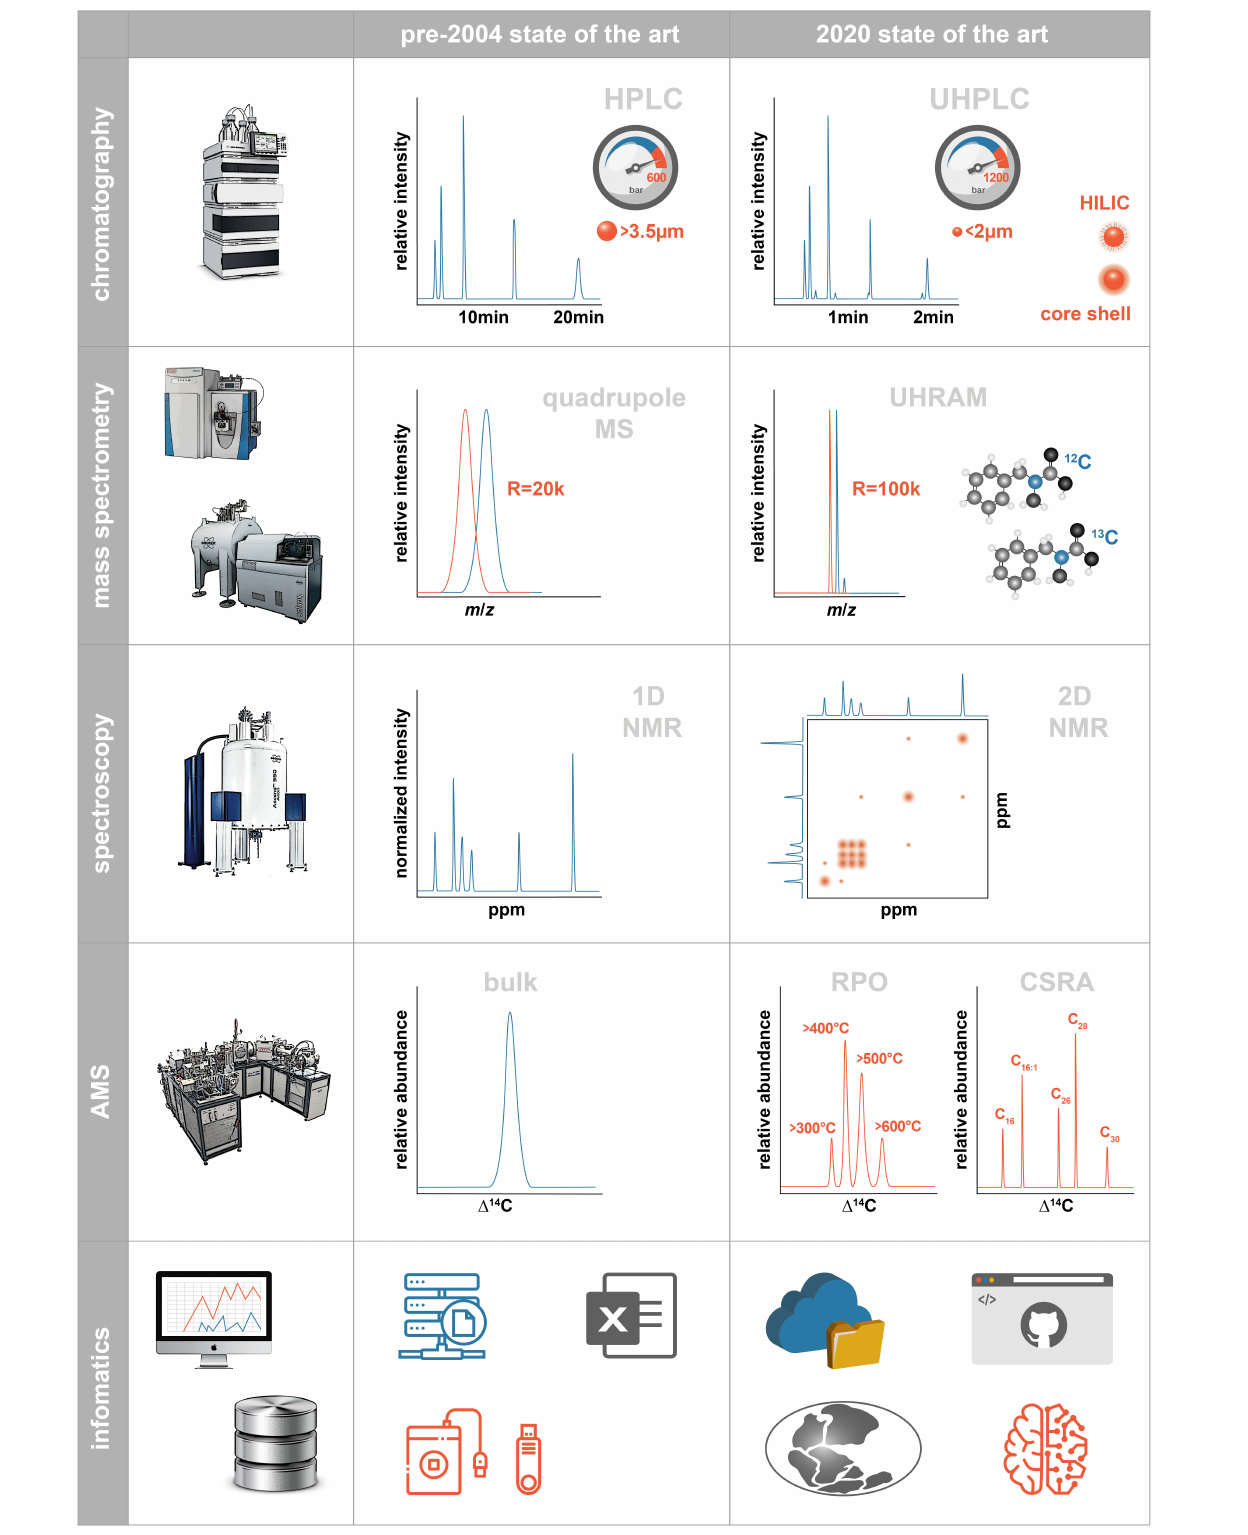
Frontiers in Marine Science |